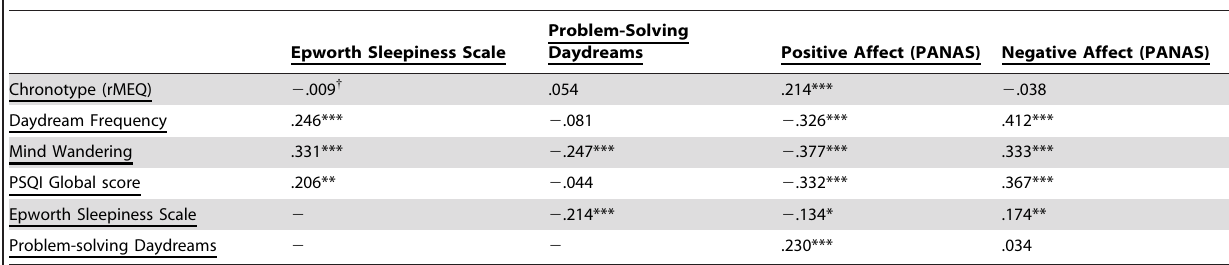
Table 6. Correlations with daytime sleepiness, positive affect, negative affect, and problem-solving daydreams.